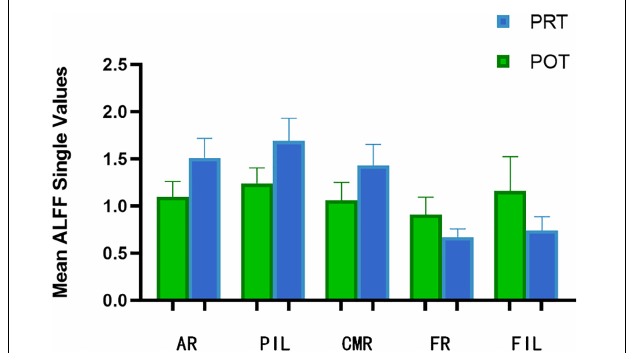
FIGURE 3 | The mean ALFF values between POT and PRT. ALFF, amplitude of low-frequency fluctuation; PRT, pre-rTMS; POT, post-rTMS; L-left; R-right; AR, Angular_R; PIL, Parietal_Inf_L; CMR, Cingulum_Mid_R; FR, Fusiform_R; FIL, Frontal_Inf_Orb_L.